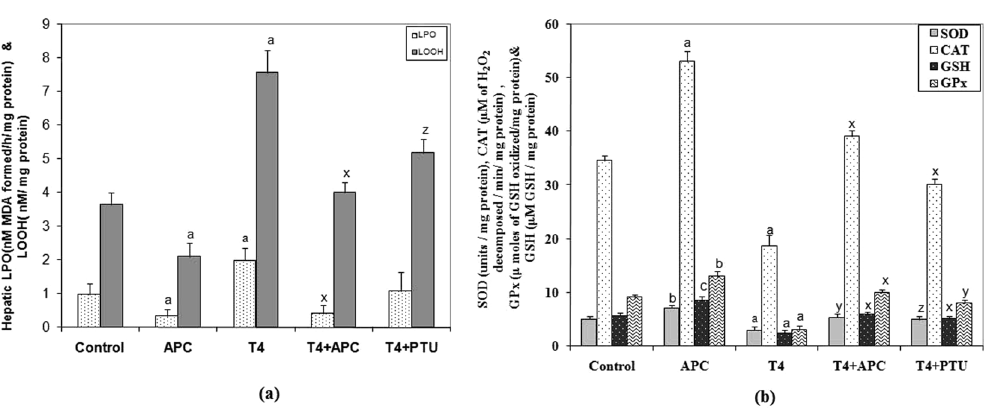
Figure 4. ( a ) Changes in LPO ( nM MDA formed/h/mg protein) and lipid hydroperoxides (LOOH, nM/mg protein) in the hepatic tissues of APC (2.0 mg/kg/d) alone or T 4 + APC or T 4 + PTU treated animals. Each vertical bar represents the mean ± SEM. (n = 7). a P < 0.001 and c P < 0.05 as compared to the respective control value, whereas x P < 0.001 as compared to the L-T 4 treated animals. ( b ) Activities of SOD (units/mg protein, CAT ( µ M of H 2 O 2 decomposed/minute/mg protein), GPx ( μ moles of GSH oxidized/mg protein) and GSH ( μ MGSH/mg protein) in liver tissues following the administration of either T 4 alone or with APC. Each vertical bar represents the mean ± SEM (n = 7). a P < 0.001, b P < 0.01 and c P < 0.05 as compared to the respective control value. x P < 0.001, y P < 0.01 and z P < 0.05 as compared to the respective value of the T 4 -induced